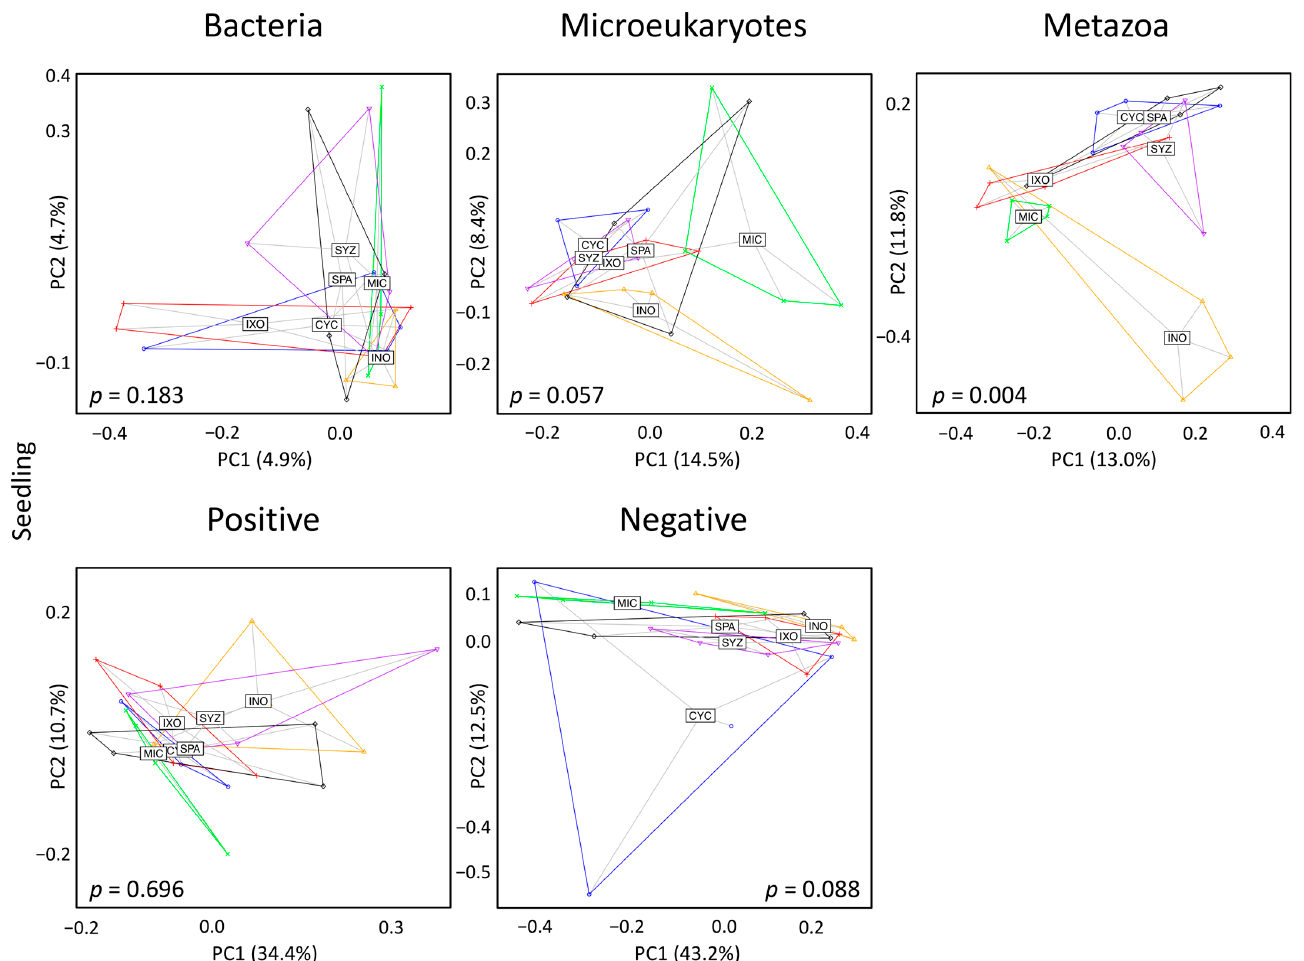
Figure 3. Shannon and Chao1 metrics in seedling and tree stages. CYC: Cyclophyllum barbatum , INO: Inocarpus fagifer , IXO: Ixora mooreensis , MIC: Miconia calvescens , SPA: Spathodea campanulata , SYZ: Syzygium malaccense . Dashed lines indicate signi fi cant pairwise comparisons.